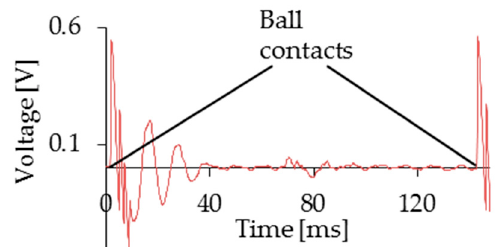
Figure 2. Open circuit voltage measured at one coil of the hollow cylinder at 9 Hz and excited with 3.1 mm amplitude corresponding to an acceleration of 9.9 mm/s 2